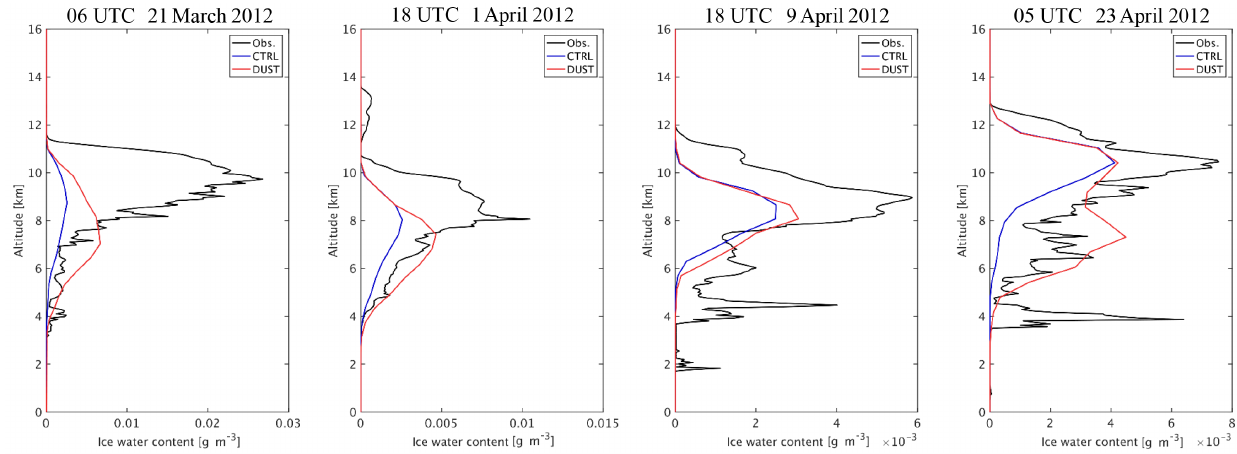
Figure 10. Vertical profiles for the mean observed IWC from CALIPSO and the simulated IWC from CTRL and DUST for dust events on 21 March and 1, 9, and 23 April